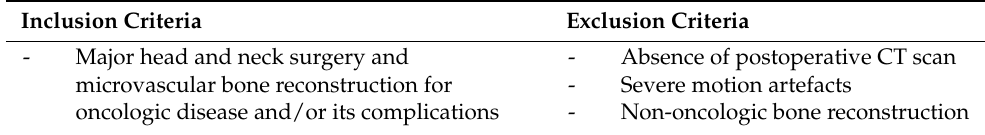
Table 1. Inclusion and exclusion